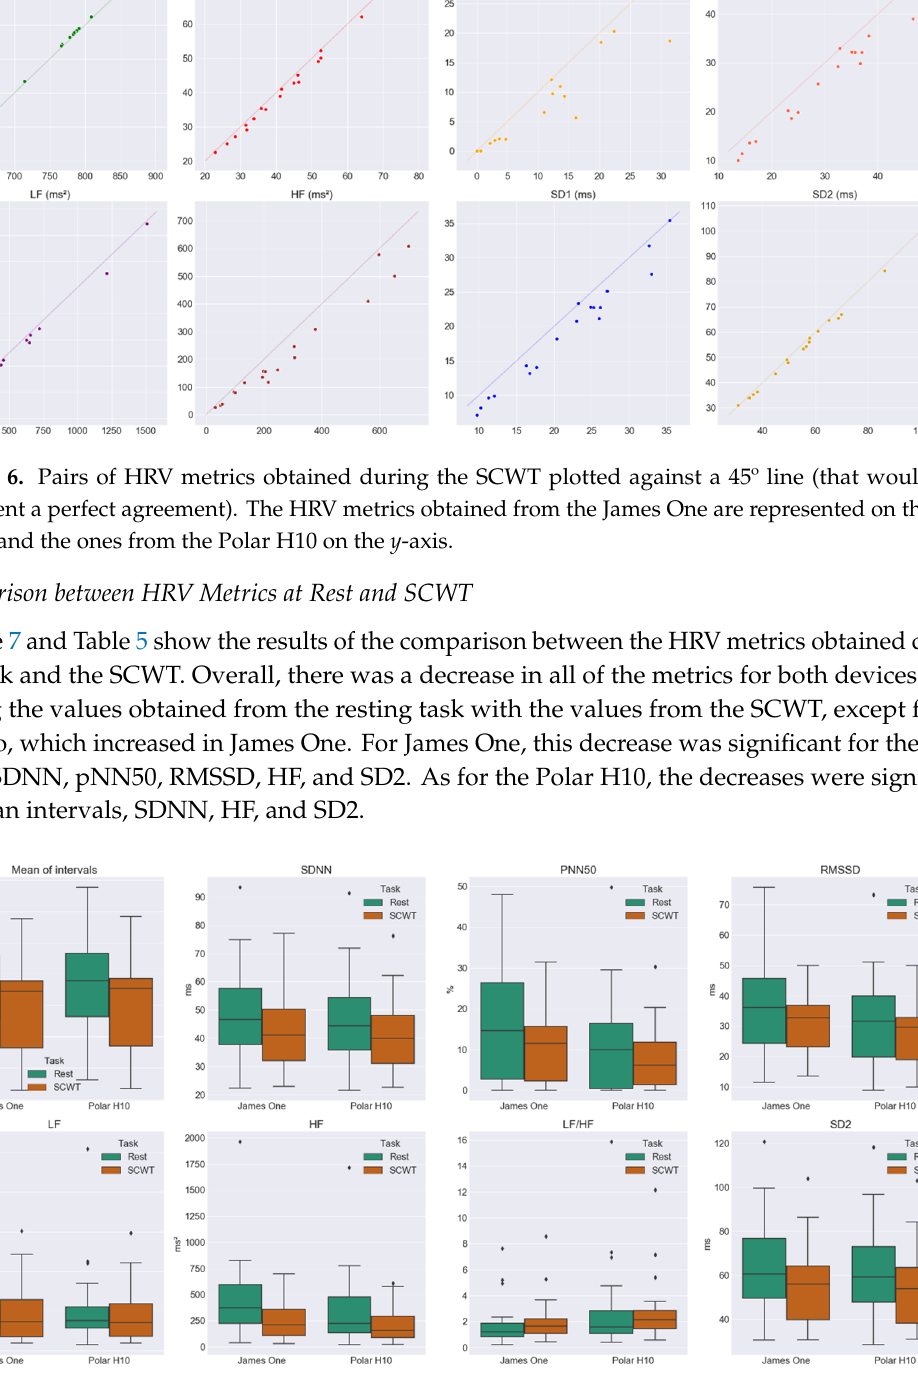
Figure 7. Box plots of the comparison between the HRV metrics obtained during the rest task and the SCWT. Each boxplot is divided by a bar that represents the median (50th percentile). The spaces between the middle bar and the top and the bottom of the box indicate the 75th and 25th percentiles, respectively. The IQR is the distance between the 75th and 25th percentiles. The whiskers that extend from the boxes represent the maximum (75th + 1.5 × IQR) and the minimum (25th − 1.5 × IQR) limits, in which a value is not regarded as an outlier. Values plotted outside these whiskers are considered outliers and are shown as ♦ .